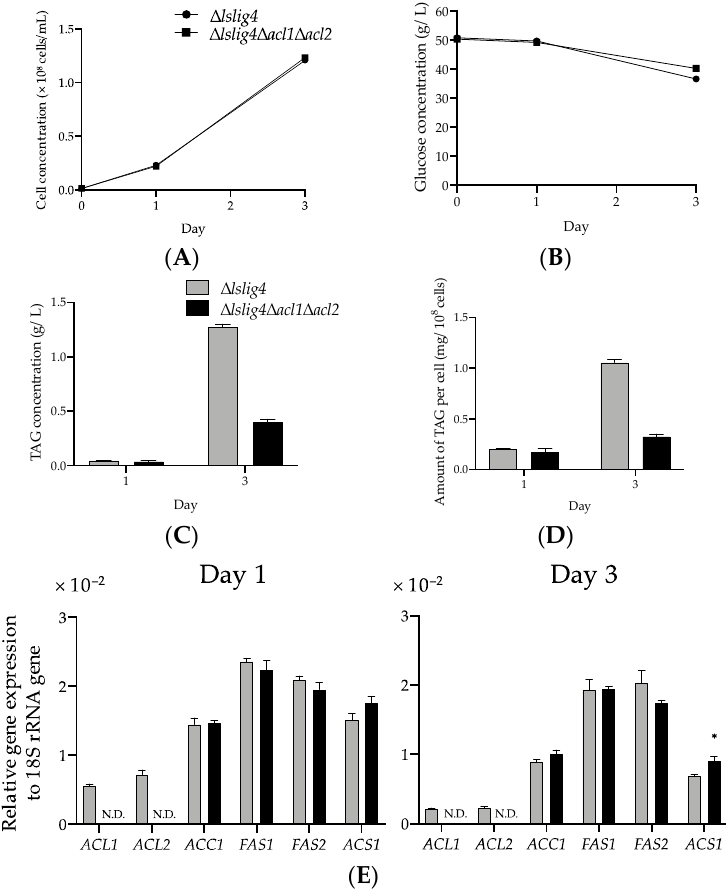
Figure 6. The effect of ATP-citrate lyase deletion on TAG synthesis on an S medium containing glucose and acetate. Symbols: closed circles, ∆ lslig4 ; closed squares, ∆ lslig4 ∆ acl1 ∆ acl2 ; gray bars, ∆ lslig4 ; black bars, ∆ lslig4 ∆ acl1 ∆ acl2 . N.D. indicates not detected. ( A – E ) The analysis of cell concentration, glucose concentration, TAG concentration, amount of TAG per cell, and relative expression levels of genes involved in acyl-CoA synthesis were performed as described in Figure 5, except that the S medium containing glucose was replaced with an S medium containing glucose and acetate. Asterisks indicate statistically significant differences between ∆ lslig4 and ∆ lslig4 ∆ acl1 ∆ acl2 ( t -test; * p <